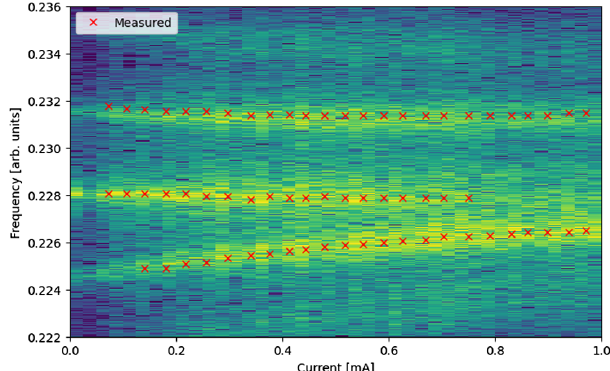
FIG. 10. Vertical tune shift up to the TMCI threshold with a single high current bunch. The large error bars are assigned due to a plateau in the measured bunch spectrum. The TMCI occurred at I ¼ 0 . 44 mA. b